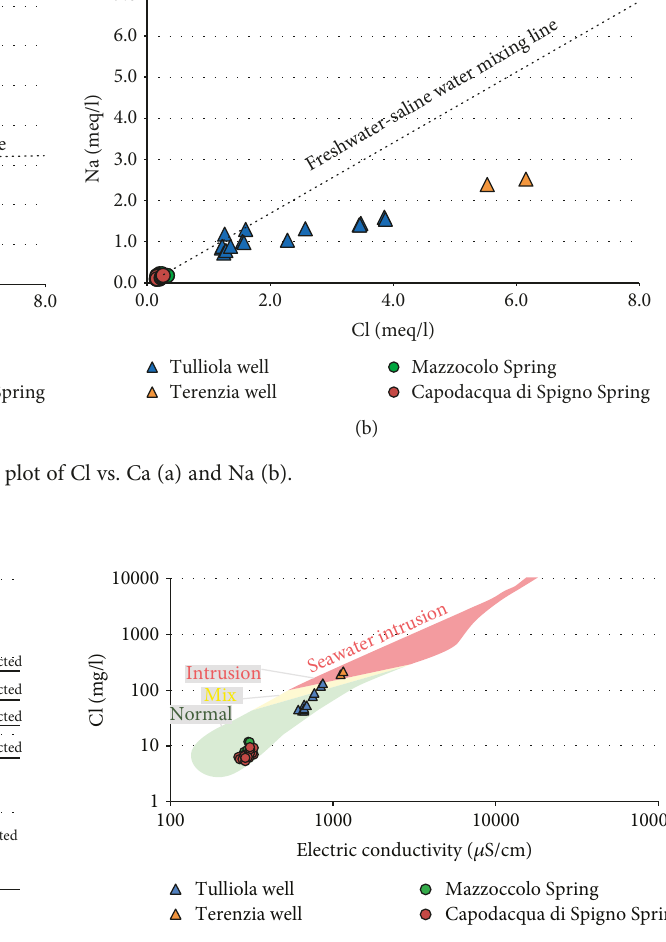
Figure 13: Chloride-EC bivariate plot to de fi ne mixing and seawater intrusion (based on Kelly approach, ratio. 3